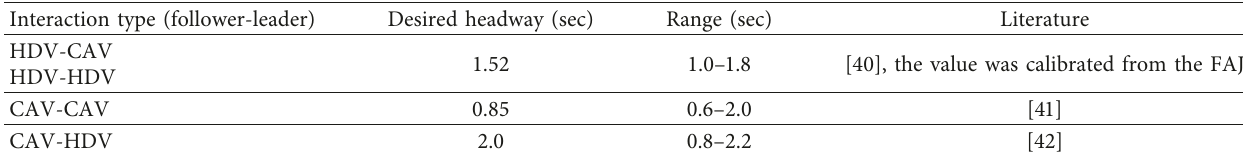
Table 3: Value for the desired